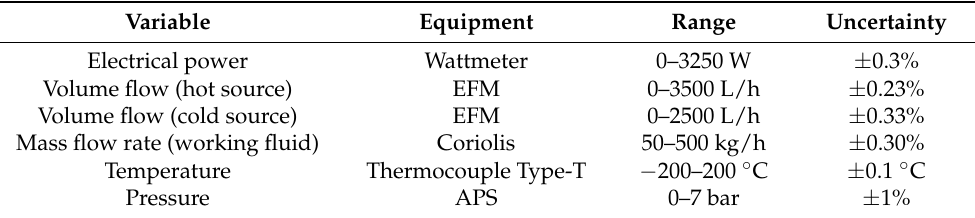
Table 1. Uncertainty of measurement equipment.